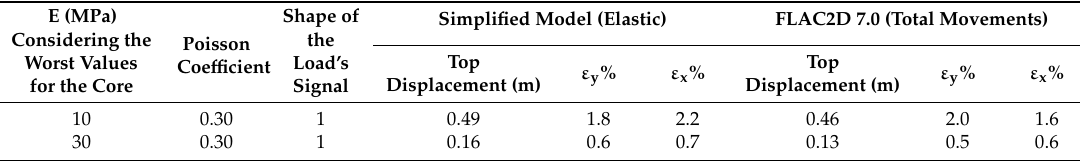
Table 5. Results obtained with the simplified model and with FLAC2D 7.0 code, comparison considering transverse deformation of the